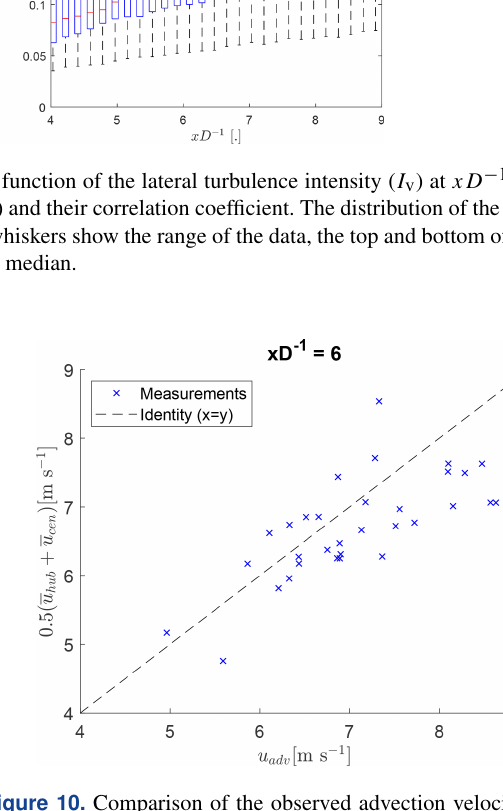
Figure 10. Comparison of the observed advection velocities with an estimation based on the average of the mean wind speed and the velocity at the wake